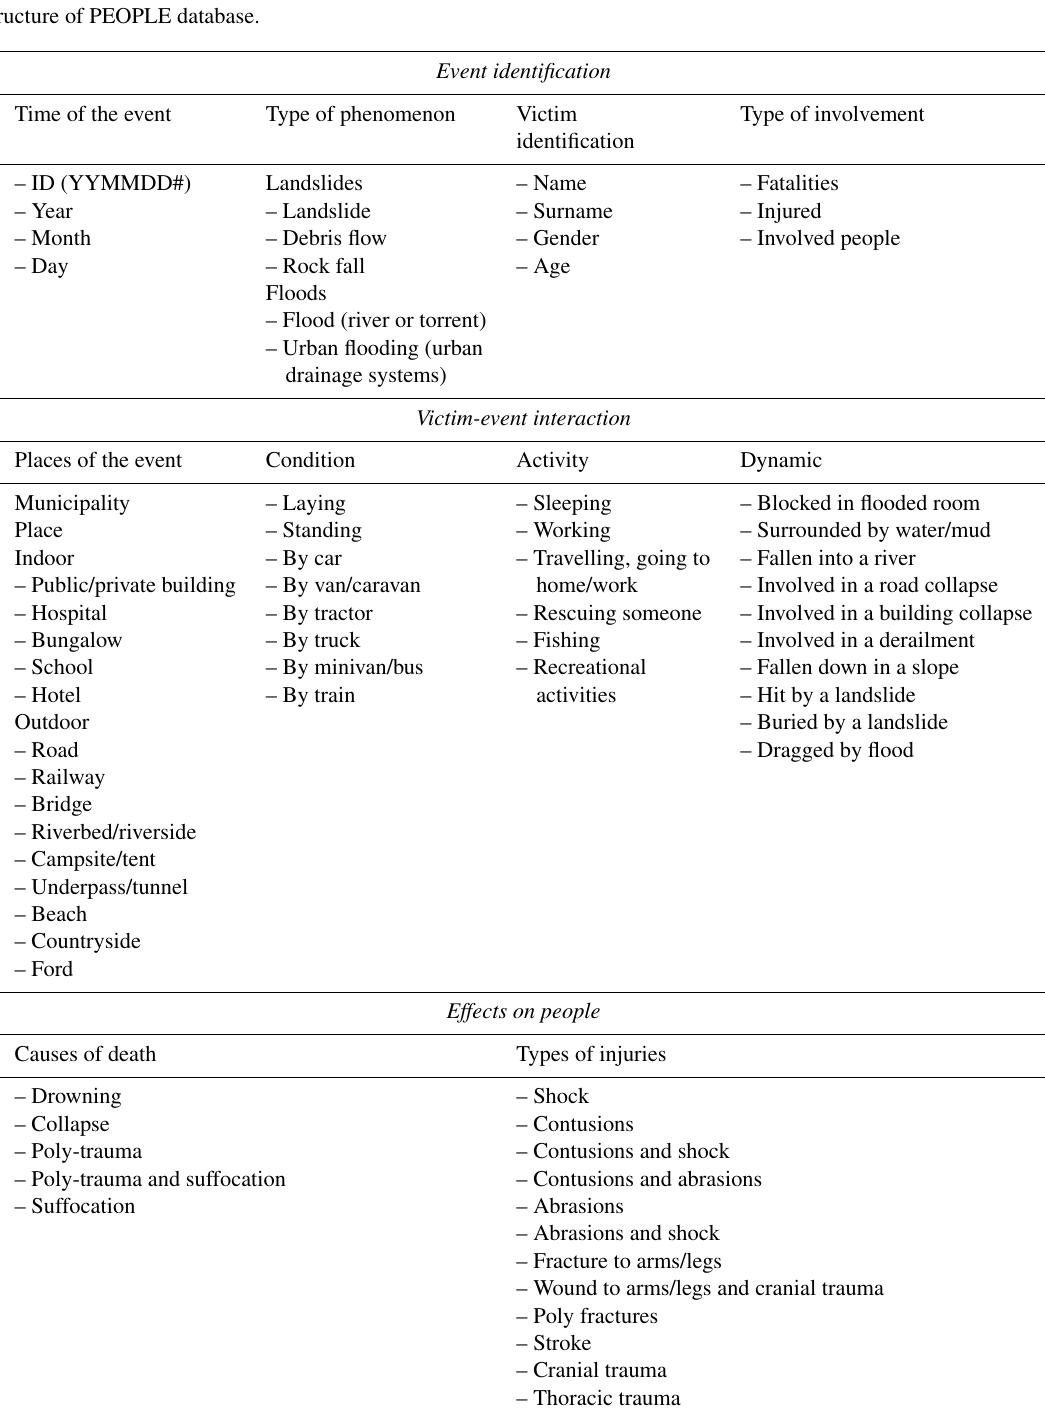
Table 1. Structure of PEOPLE